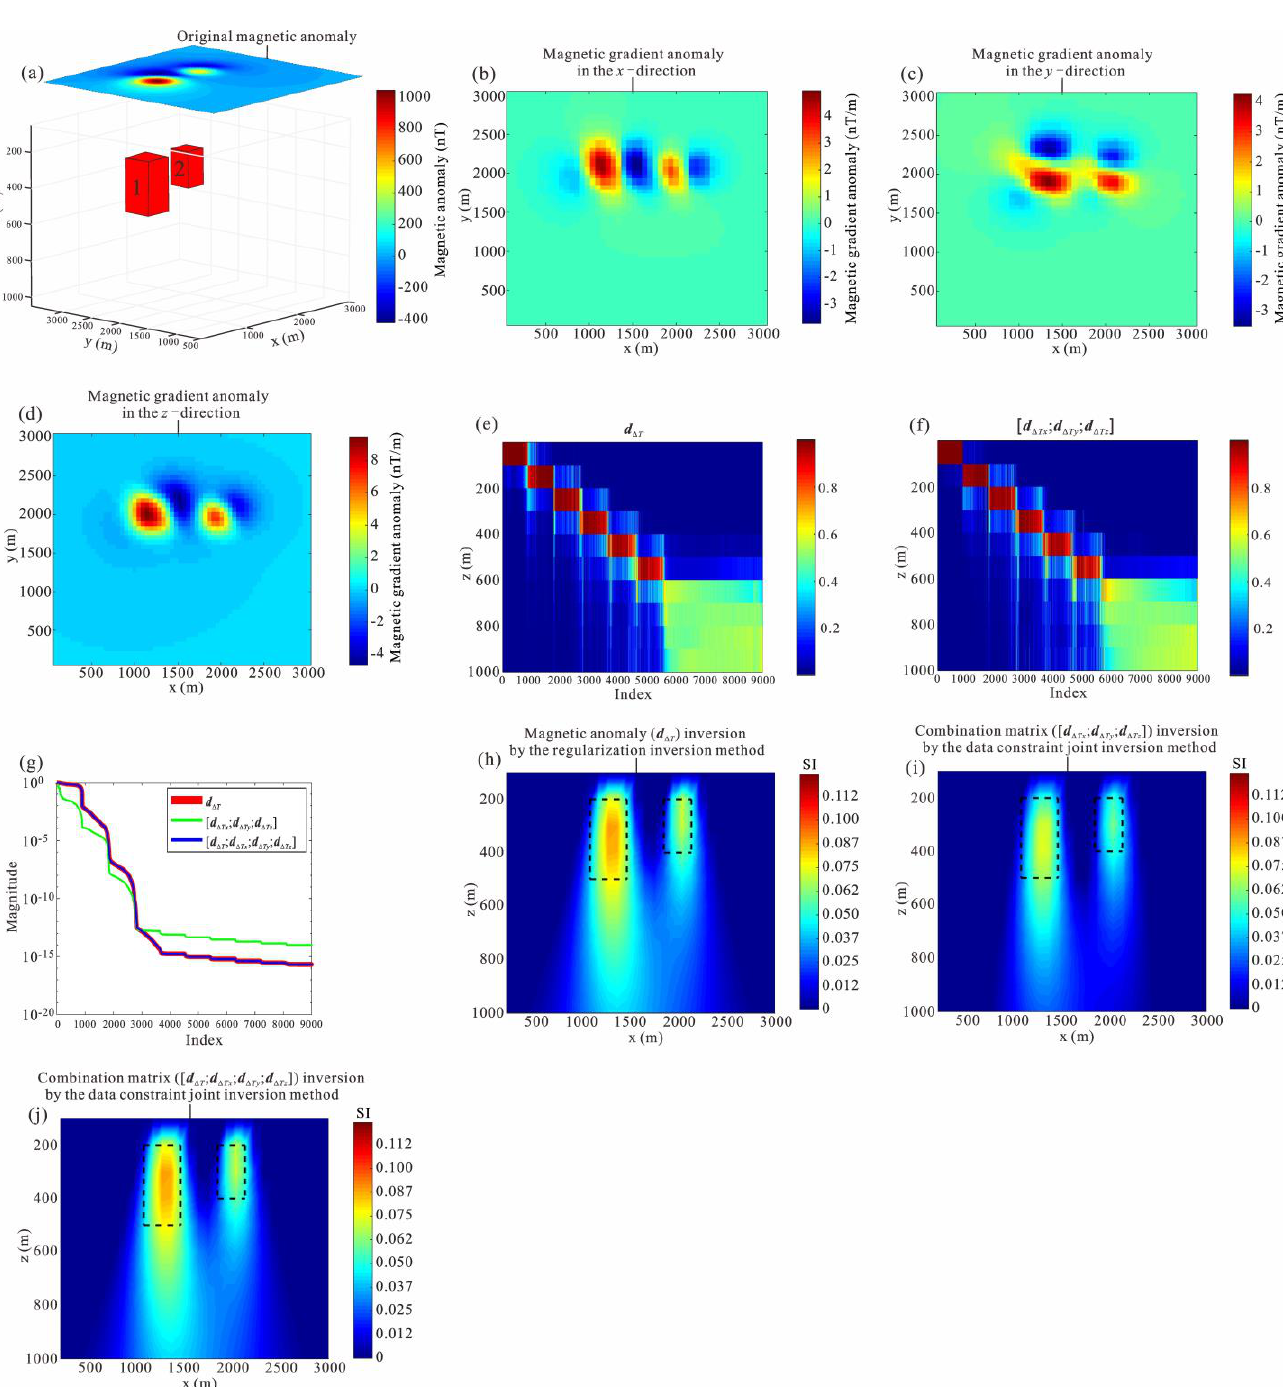
d ) inversion and combination matrix ( T  (cid:104) (cid:105) d ∆ T ; d ∆ T ; d ∆ T ) inver- x y z (cid:104) (cid:105) d ∆ T ; d ∆ T ; d ∆ T ; d ∆ T ) x y z